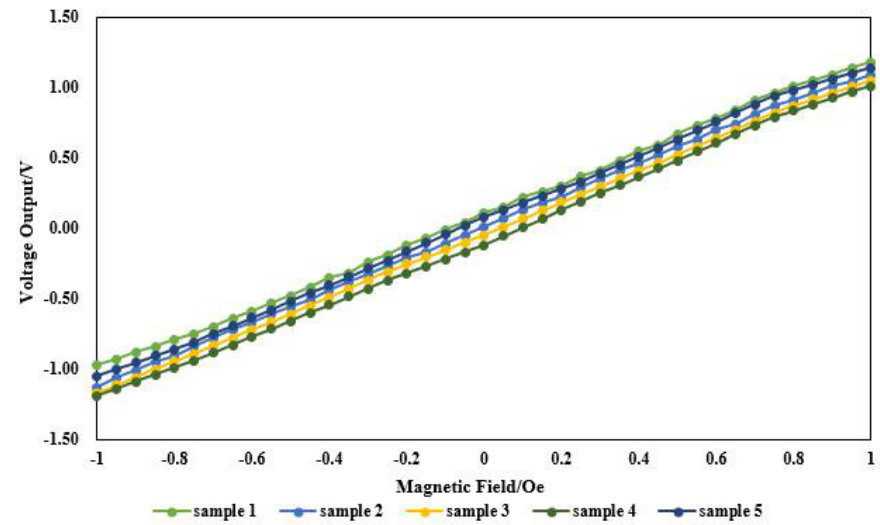
Figure 9. Output characteristic curve of the magnetic sensors.